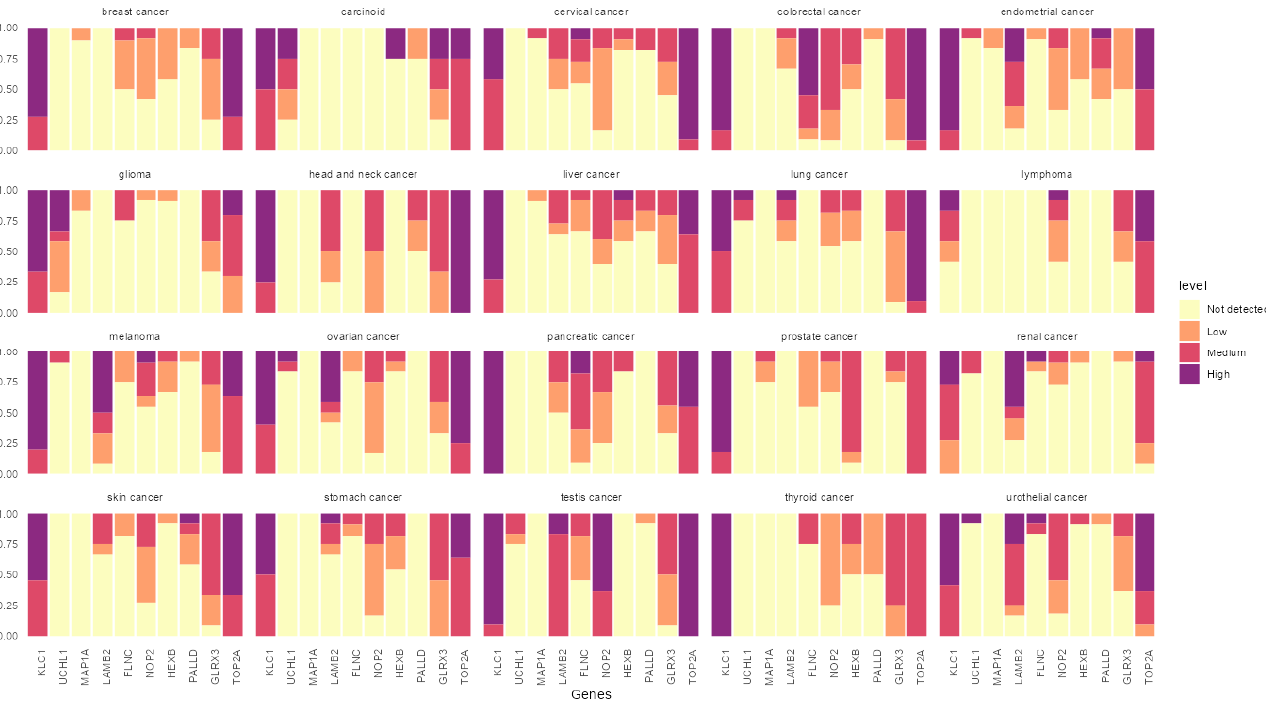
Figure 5. Expression of candidate antigens in twenty different tumor types. Tumor expression of shortlisted candidate genes/proteins identified both SaOS-R175H and SaOS-R273H cells in various cancer types. y-axes represent the proportion of patients expressing each candidate. The color of each bar indicates the strength of expression, with red being highly expressed and yellow as low expression.